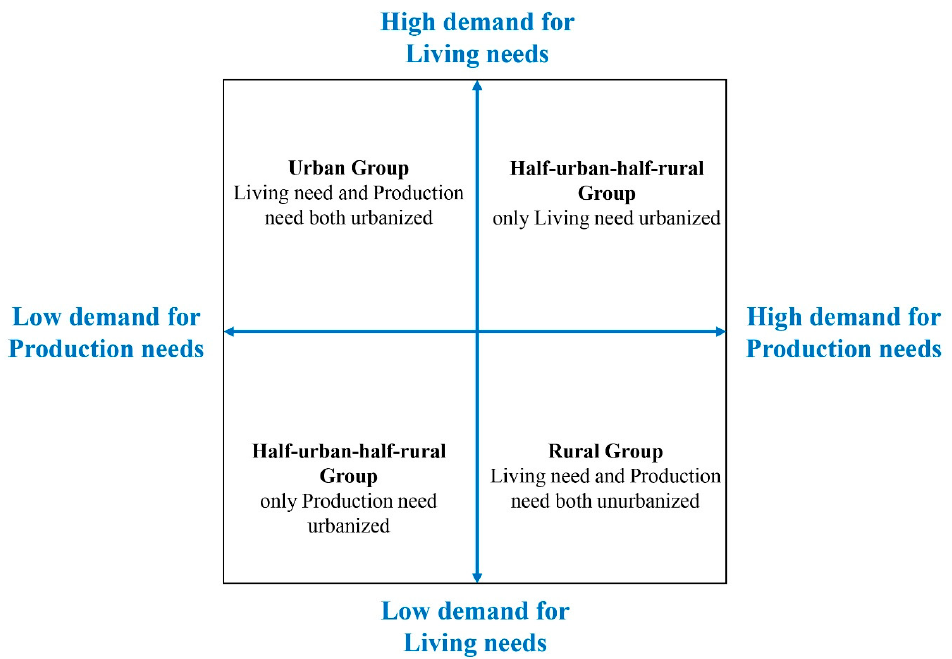
Figure 3. Framework of the model of urbanization characteristics (Source: Author).